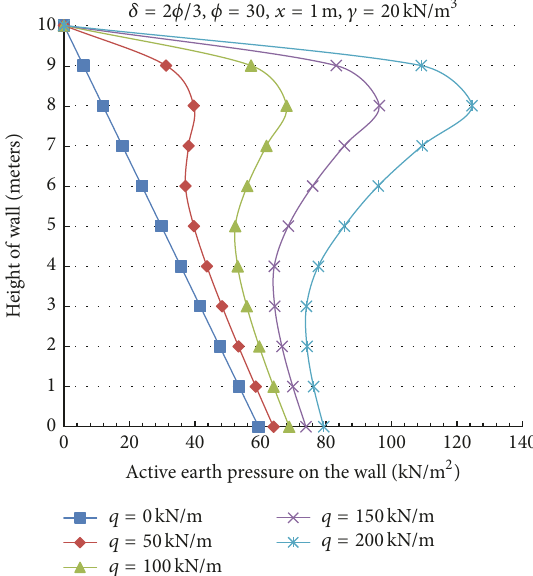
Figure 11: The total active pressure distribution on the wall for different values of line surcharge for 𝜙 = 30